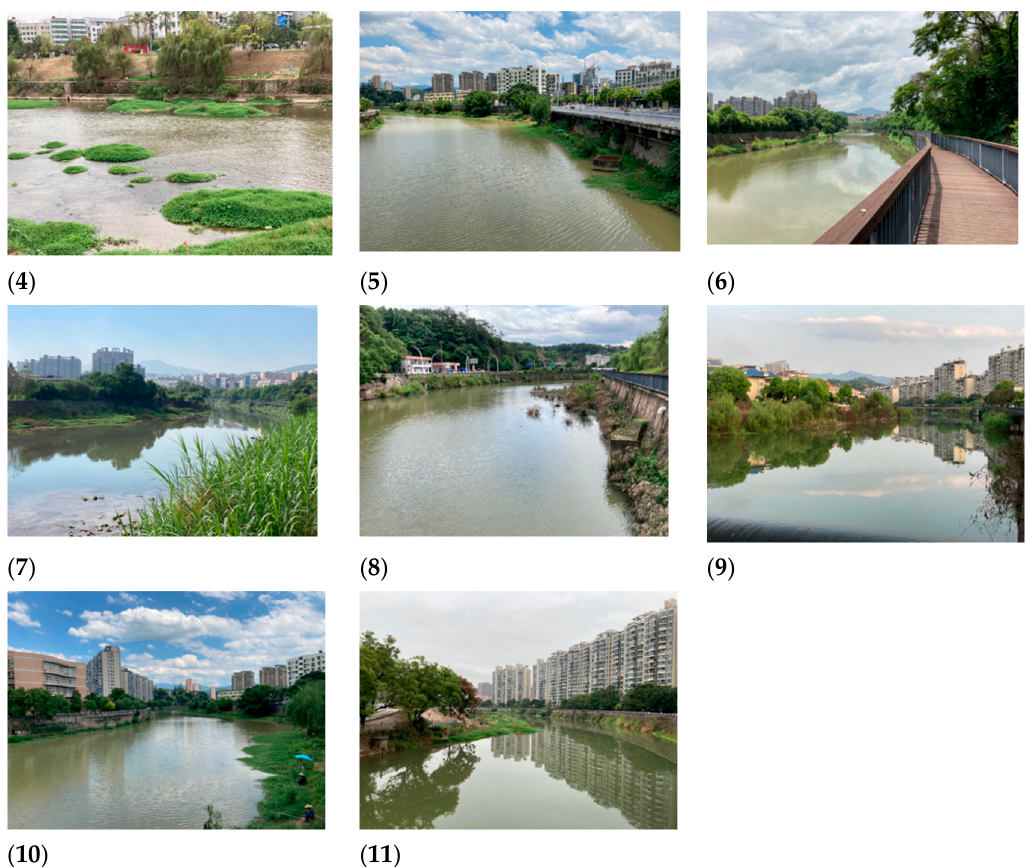
Figure A2. Images collected for the second survey on the Baxi stream. ( 1 , 4 ) A cross-river view taken from the reach unaffected by submerged dam. ( 2 , 6 , 7 , 8 , 11 ) A flow-axis view taken from the reach unaffected by submerged dam. ( 3 , 5 , 9 , 10 ) A flow-axis view taken from the reach affected by submerged dam. Images 5 and 6 have a high degree of artificial facilities ( I R + B R > 20%), while image 1 has less human intervention and is closer to its natural state.